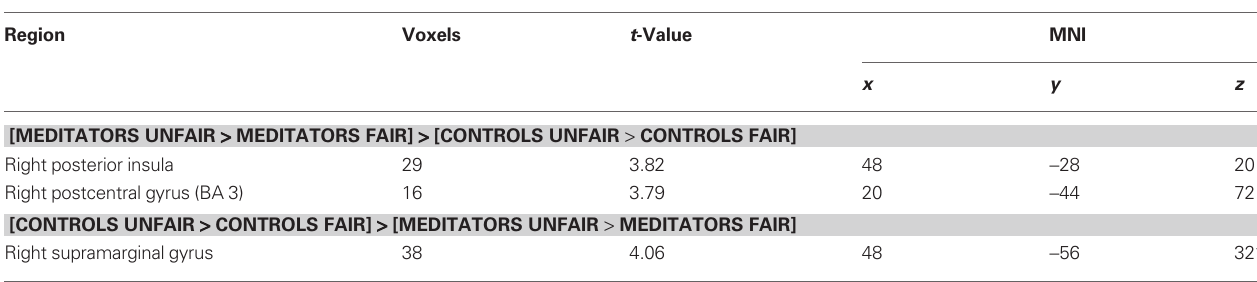
Table 4 | group × offer type (unfair, fair) interactions for human conditions.